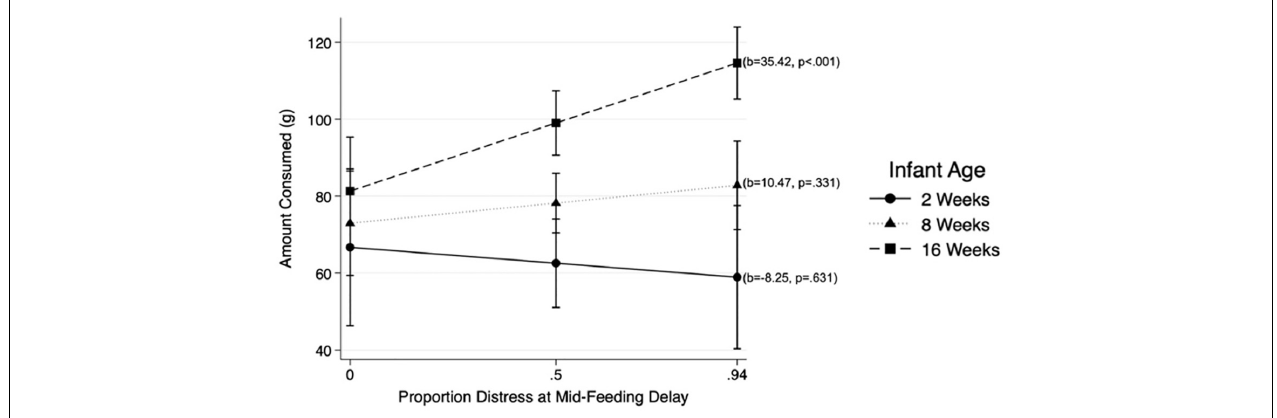
FIGURE 2 | Associations between distress at Mid-Feeding Delay and amount consumed at different infant ages: 2, 8, and 16